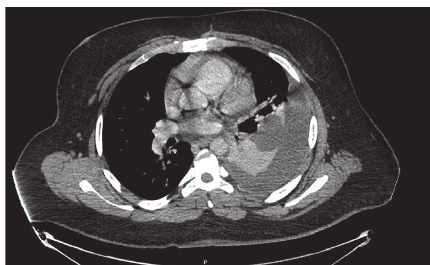
Figure 3: Pleural effusion and residual splenic abscess of 2 ×